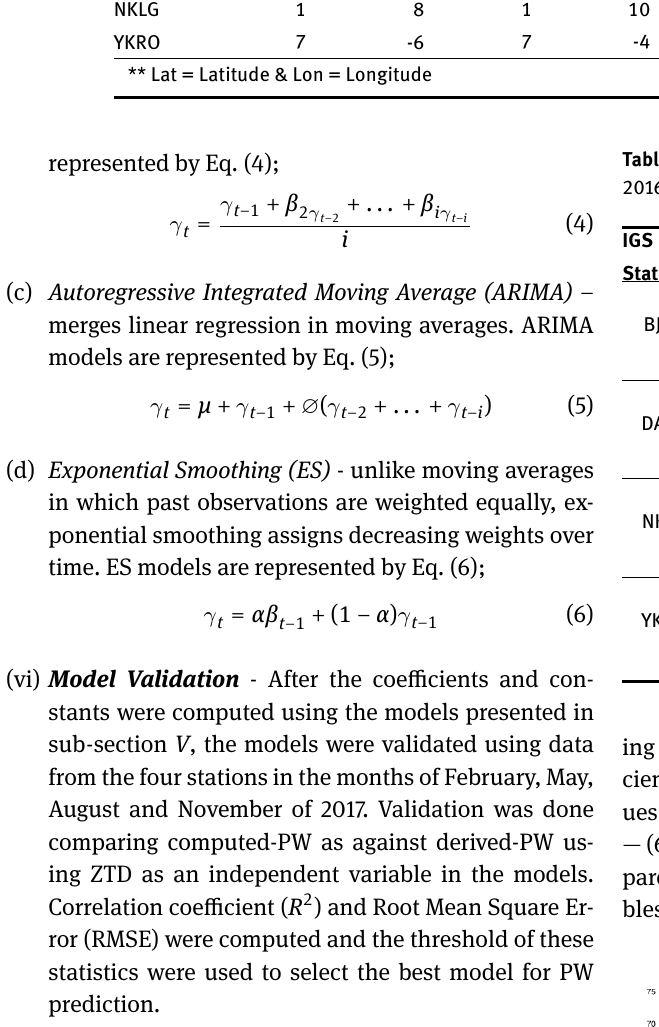
Table 2: The grid points used in scaling down the ERA-Interim model for weather data retrieval Top Left Top Right Bottom Left Site ID